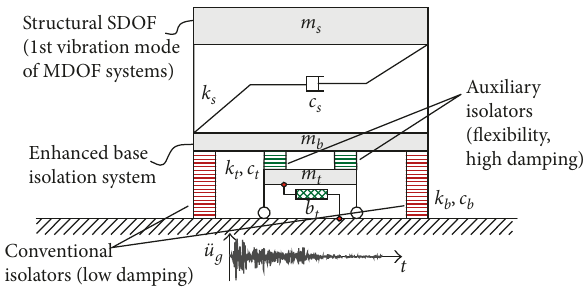
Figure 12: Schematic arrangement of the proposed base isolation system comprising two sets of isolators to attach the inerter to the